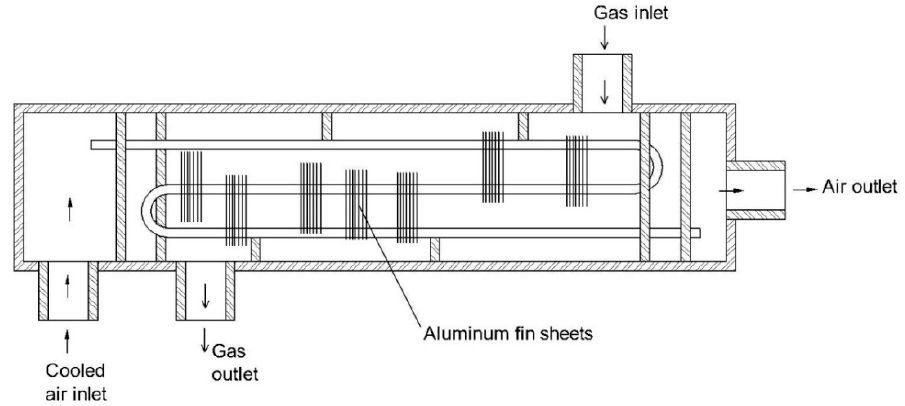
Figure 2. Structure of an air-to-air heat exchanger [64].